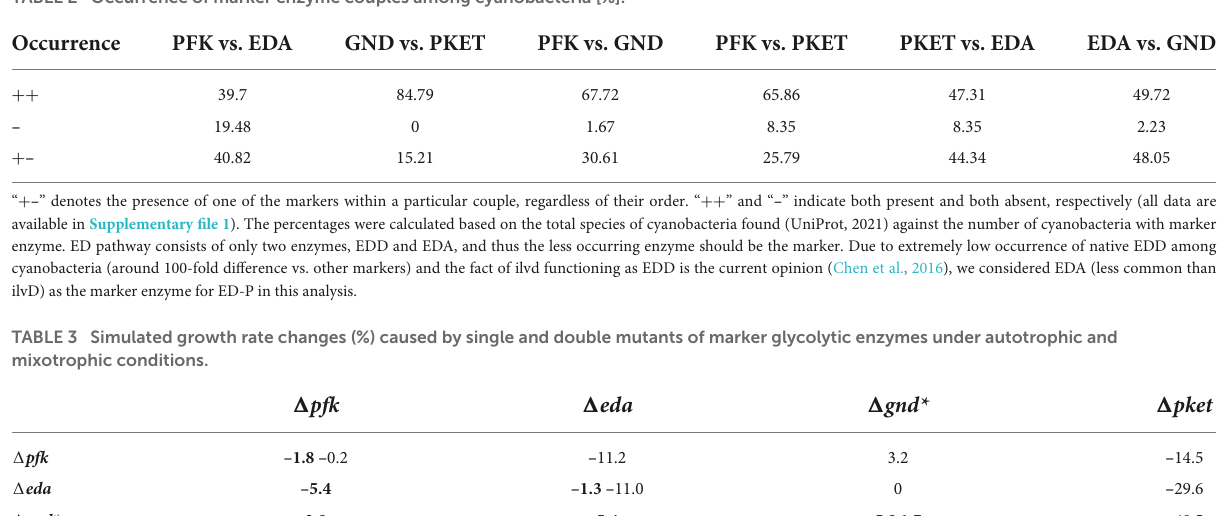
TABLE 2 Occurrence of marker enzyme couples among cyanobacteria [%].